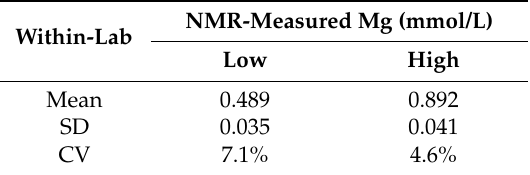
Table 1. Within-lab imprecision of ionized Mg measured on the Vantera Clinical